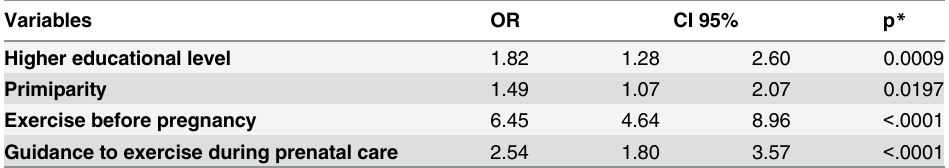
Table 4. Logistic regression results for odds of exercising during pregnancy according to women characteristics.